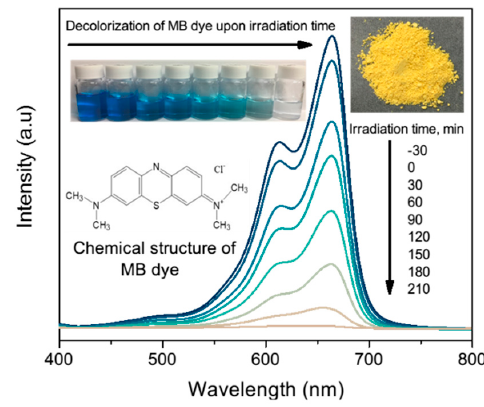
Figure 12. Rate of decolorization of methylene blue dye for BiVO 4 microspheres calcined at 400 °C.